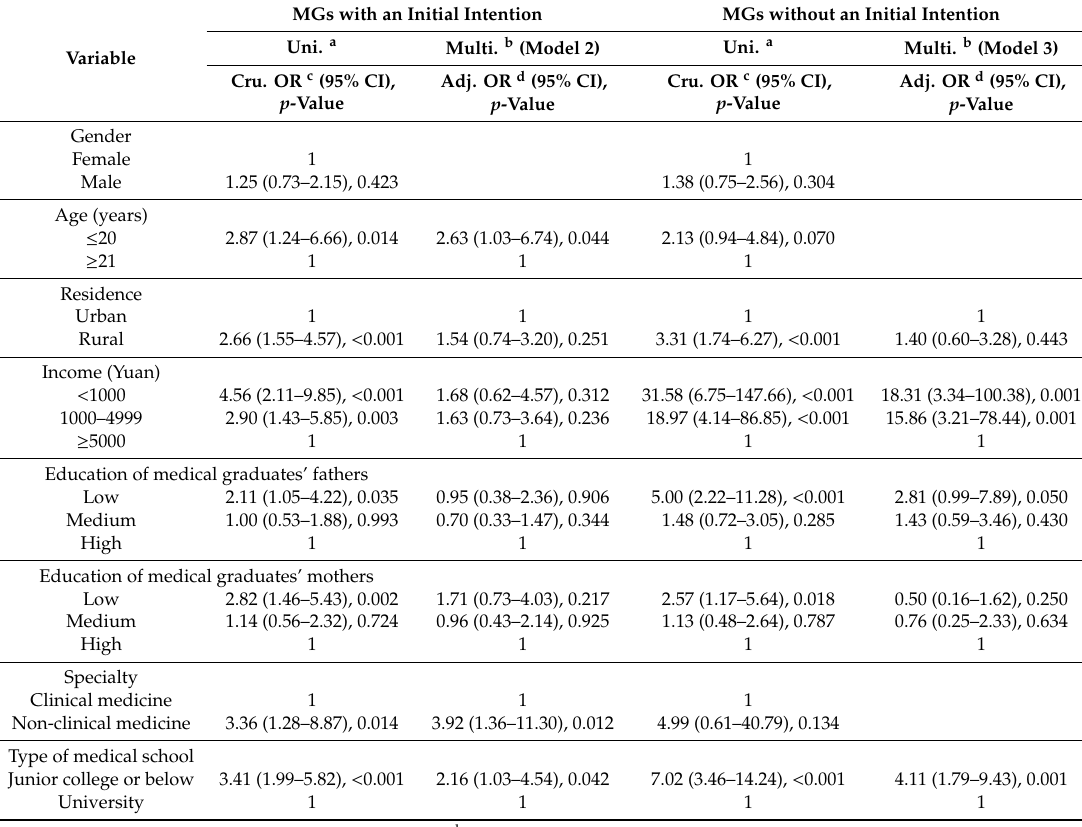
Table 4. Binary logistic regression on current job choices for rural practice among medical graduates (MGs) with versus without an initial